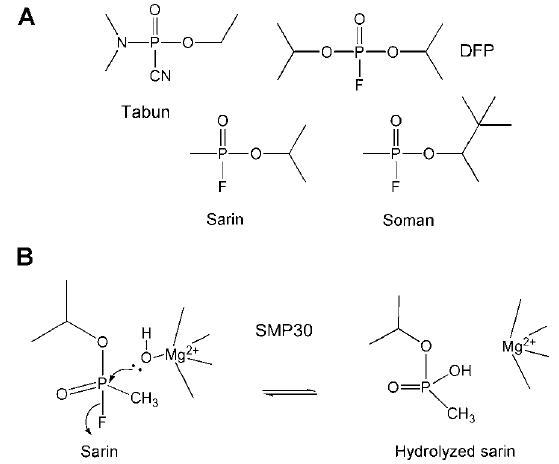
Figure 5 Organophosphates hydrolyzed by SMP30 (9). (A) Structures of tabun, DFP, sarin, and soman. (B) Hydrolysis of sarin by SMP30 and Mg 2 q